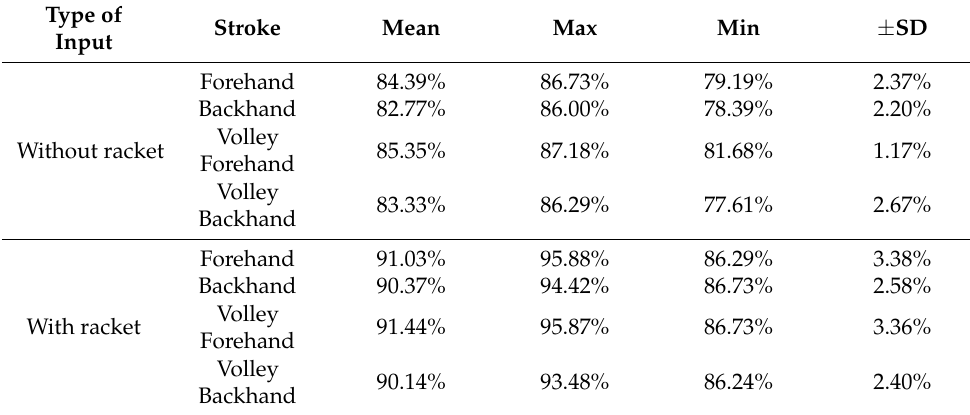
Table 5. Obtained F1 results.